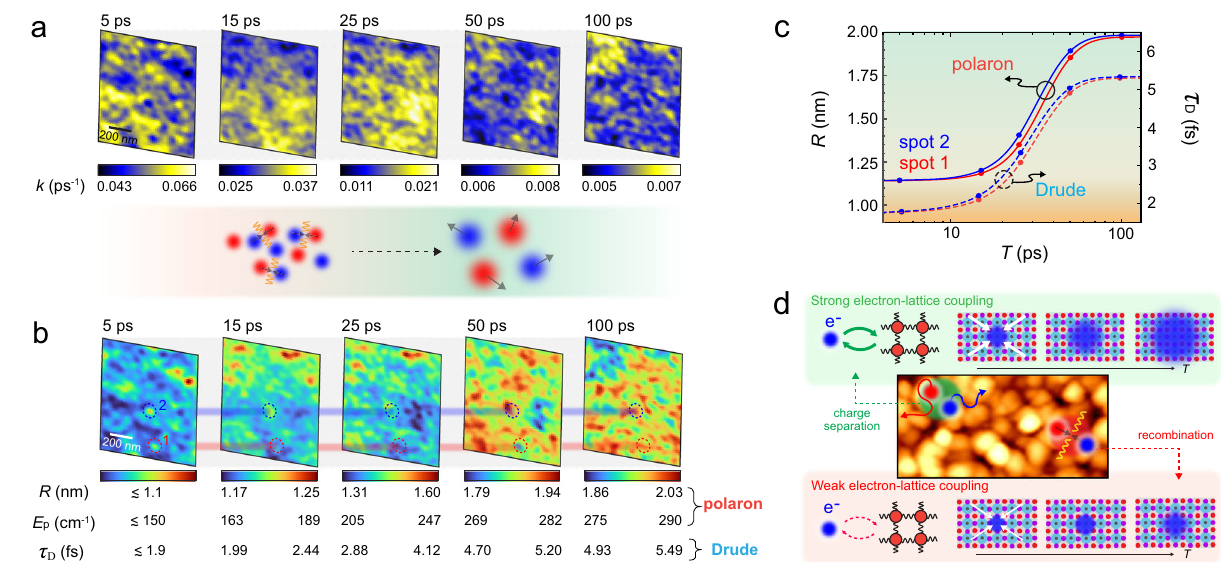
Fig. 4 | Spatio-temporal quasi-particle carrier evolution. a Instantaneous relaxationrateimagesderivedfromthesetofspatio-temporalimagesofFig.2cvia bi-exponential fi tting. b Corresponding temporal evolution of polaron effective stabilization energy E p and polaron delocalization radius R , or Drude scattering time τ D , based on the relationship derived in Fig. 3e, f. c Increase of R ( T ) (polaron absorption model) or τ D (Drude scattering time) at two selected sample locations indicatedinpanelb,showingthespatialheterogeneityinthedynamicevolutionof